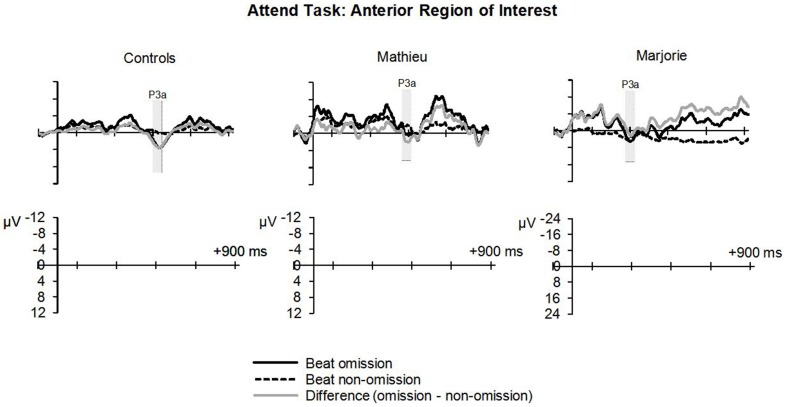
Attend task: P3a. Grand averaged ERPs elicited by deviant beat omissions and corresponding standard target beats in the attend task at the anterior region of interest for the control participants (left column), Mathieu (middle column), and Marjorie (right column). Shaded regions depict P3a mean amplitude analysis time window. Negative is plotted upward.